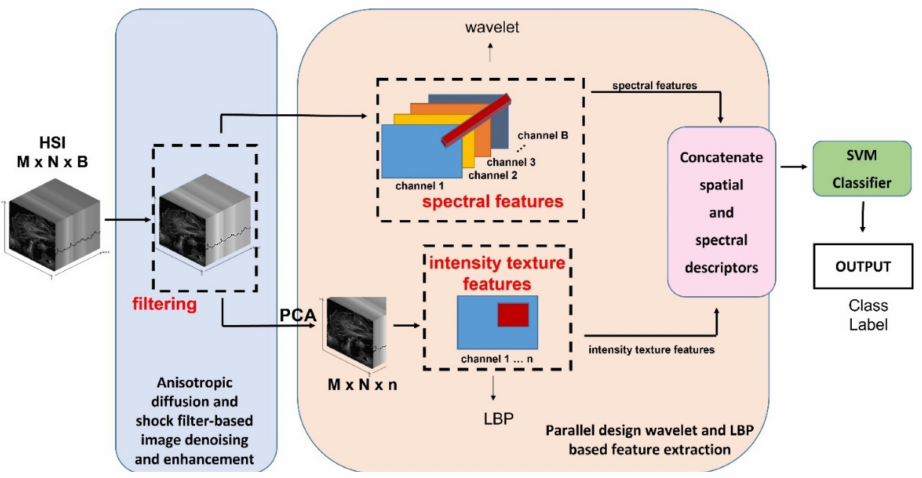
Figure 2. The parallel approach proposed for feature extraction of the hyperspectral data with mixed spatial-spectral filtering and